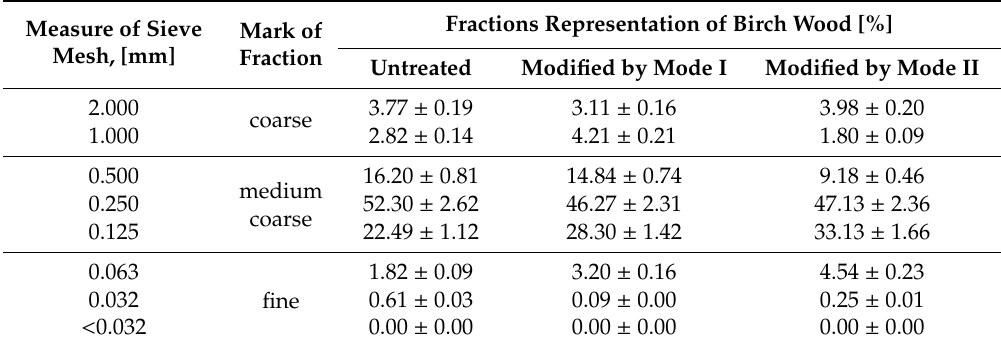
Table 4. Sawdust from the saw frame PRW-15M, average values with standard deviations.